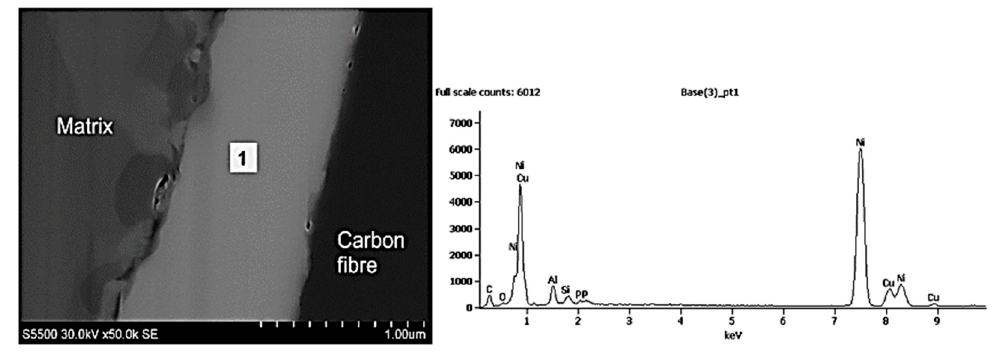
Figure 13. EDS analysis of the interface between the fibre and the aluminium alloy matrix of MMC3 sample before push-out test.